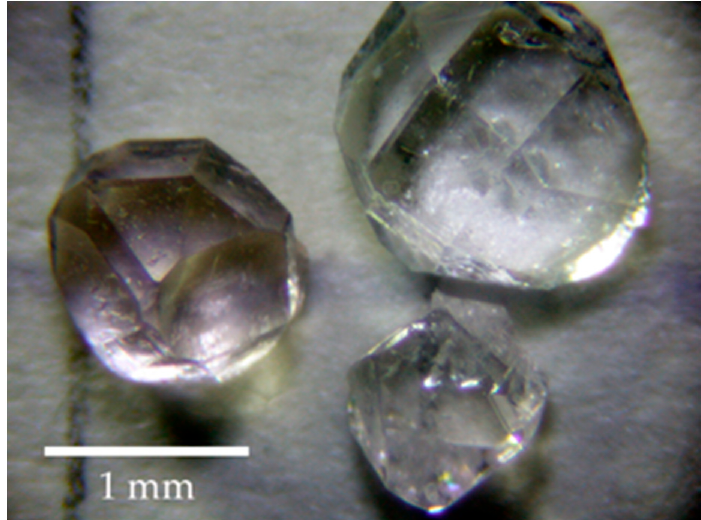
Figure 1. YMgB 5 O 10 spontaneous crystals grown from K 2 Mo 3 O 10 -based system.